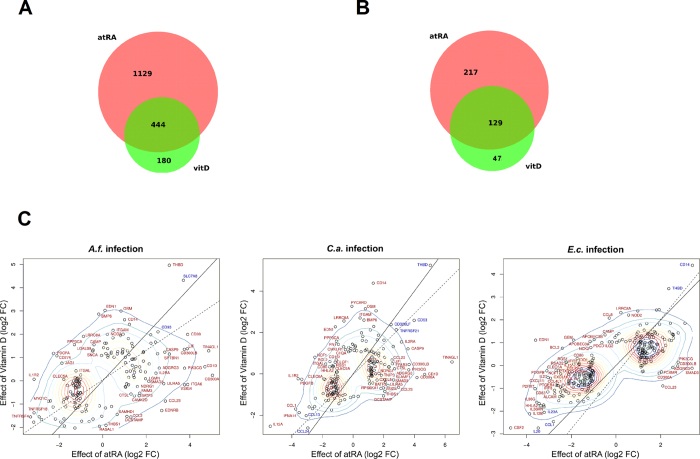
Comparison of the immunomodulatory potentials of vitamin A and vitamin D.During infection, an important overlap among the gene sets regulated by both vitamins could be revealed. Nevertheless, differential modulatory effects by each of the vitamins could be addressed among several immune-relevant genes. (A) Venn diagram showing the overlap of atRA- and vitD-regulated protein-coding genes during any of the infections. (B) Venn diagram showing the overlap of atRA- and vitD-regulated genes belonging to GO category GO:0002376 (Immune System Process). (C) Scatter plots display the differential effects of each vitamin on the expression of immune-relevant genes. Each axis depicts the vitamin-induced log2 fold change as compared to the corresponding pathogen stimulation alone. Genes written in red indicate significant differences in their regulation induced by each vitamin (real FC > 3 between the fold changes induced by atRA and vitD during infections).